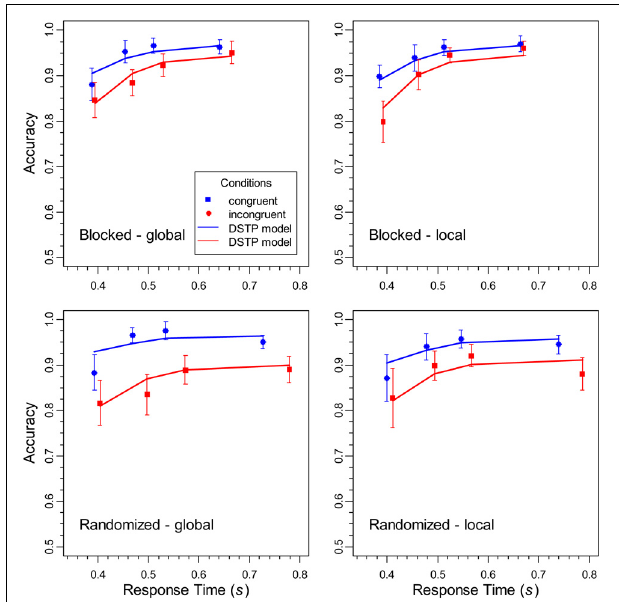
FIGURE 4 | The data points represent the conditional accuracy functions for the different conditions in the experiment, and the error bars show the 95%-confidence intervals. The solid lines represent the corresponding performance of the DSTP